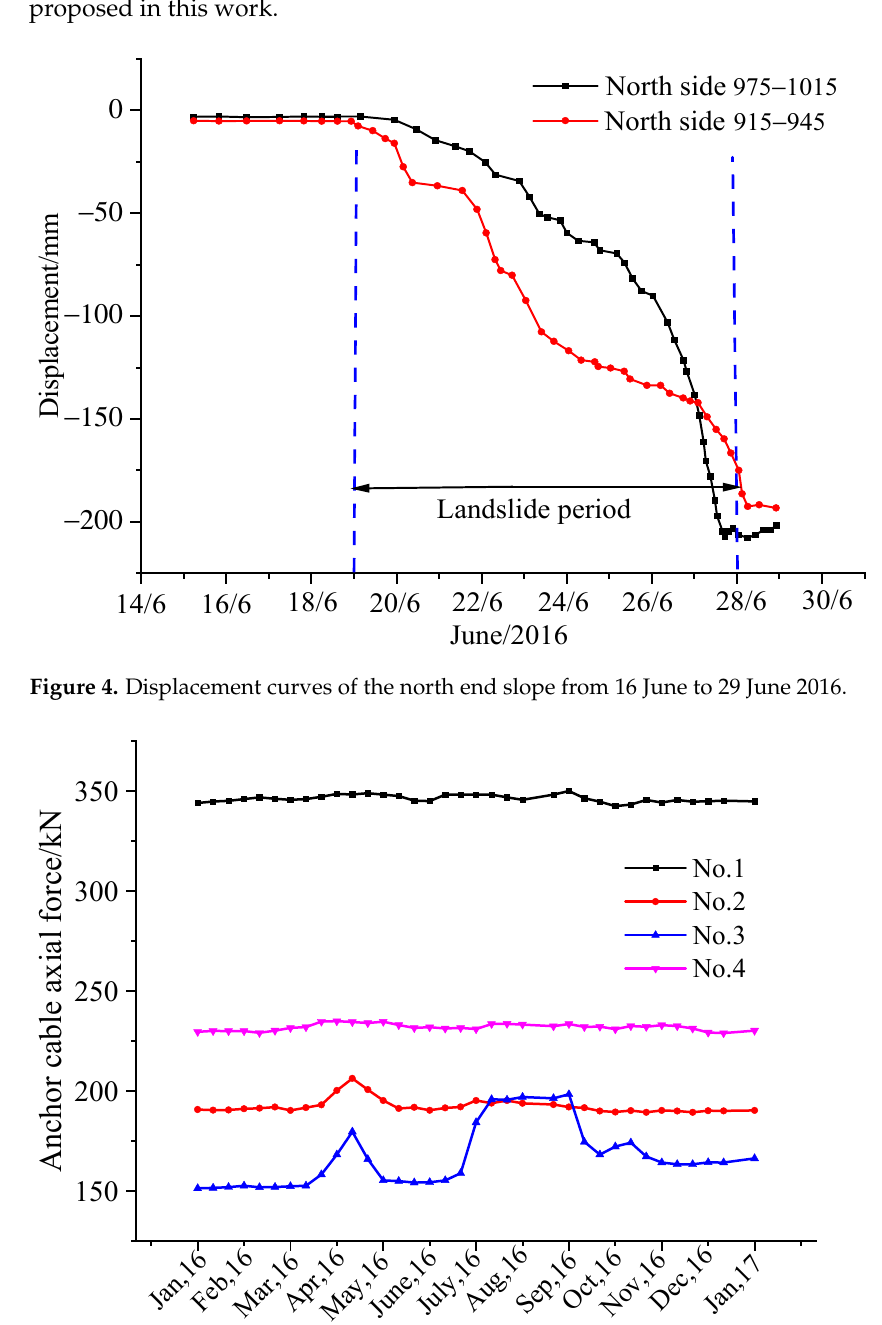
Figure 3. Field layout with 4 anchor monitoring points and regional landslide in north end slope.